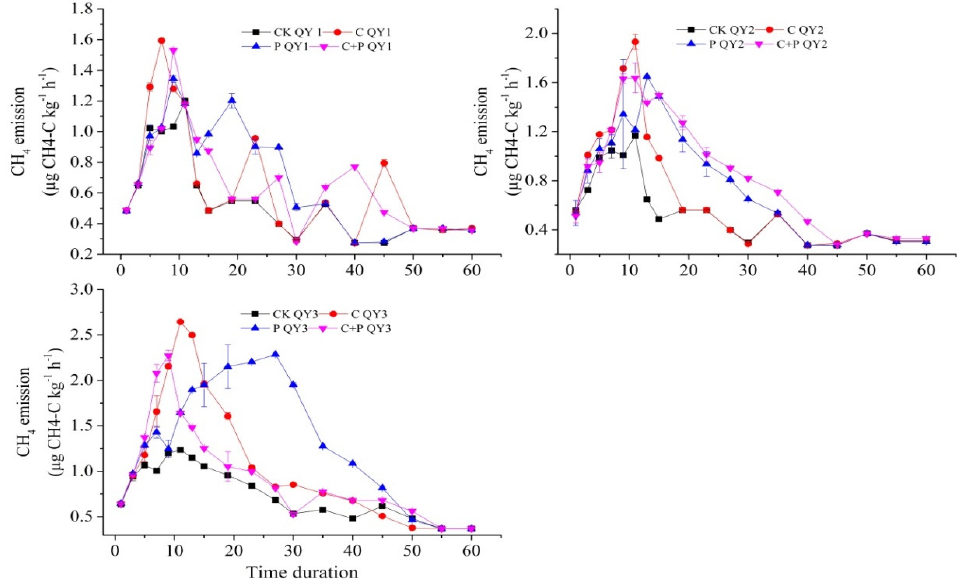
Figure 2. CH 4 emission fluxes rate from phosphorus-deficient (QY1) and phosphorus-adequate soils (QY2, QY3) with and without glucose (Glu) and/or phosphorus (P) addition per day during incubation period. CK: control; C, glucose addition; P, phosphorus addition; C + P, glucose and phosphorus addition. Error bars represent standard error (n = 3). Note: phosphorus-deficient soil is represented by QY1 and phosphorous-adequate soils are denoted by QY2 and QY3.